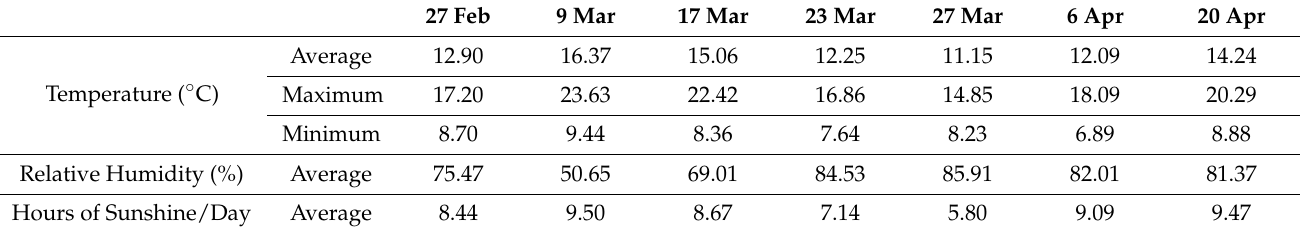
Table 1. Meteorological data provided by a station close to the experimental greenhouses in El Raal, Murcia,